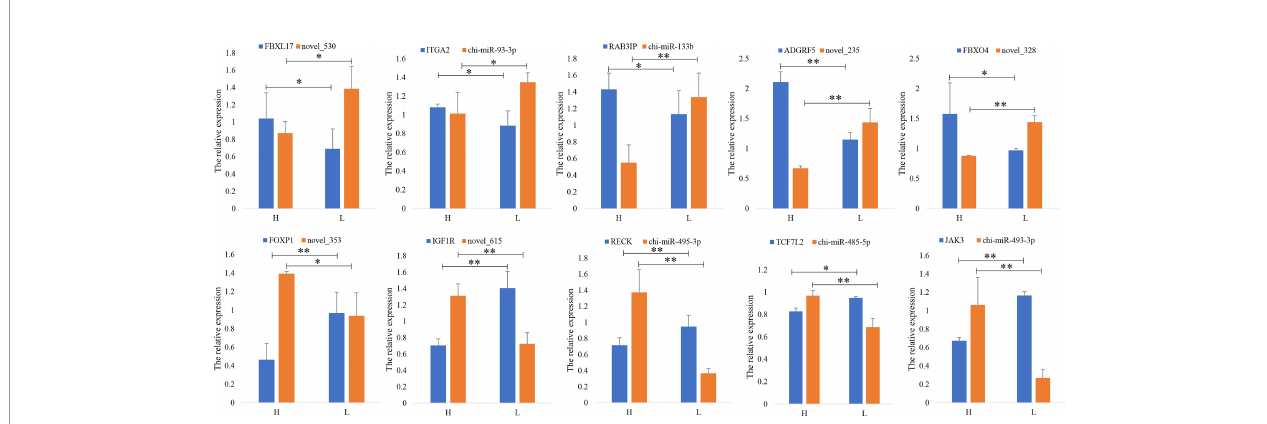
FIGURE 4 | Veri fi cation of differential gene expressions. RT-qPCR quanti fi es 10 DEM – DEG pairs in high (H)- and low (L)-proli fi cacy goat ovary. RPL19 is used as an internal control. Values are expressed as mean±SD of n =3. * p <0.05, ** p